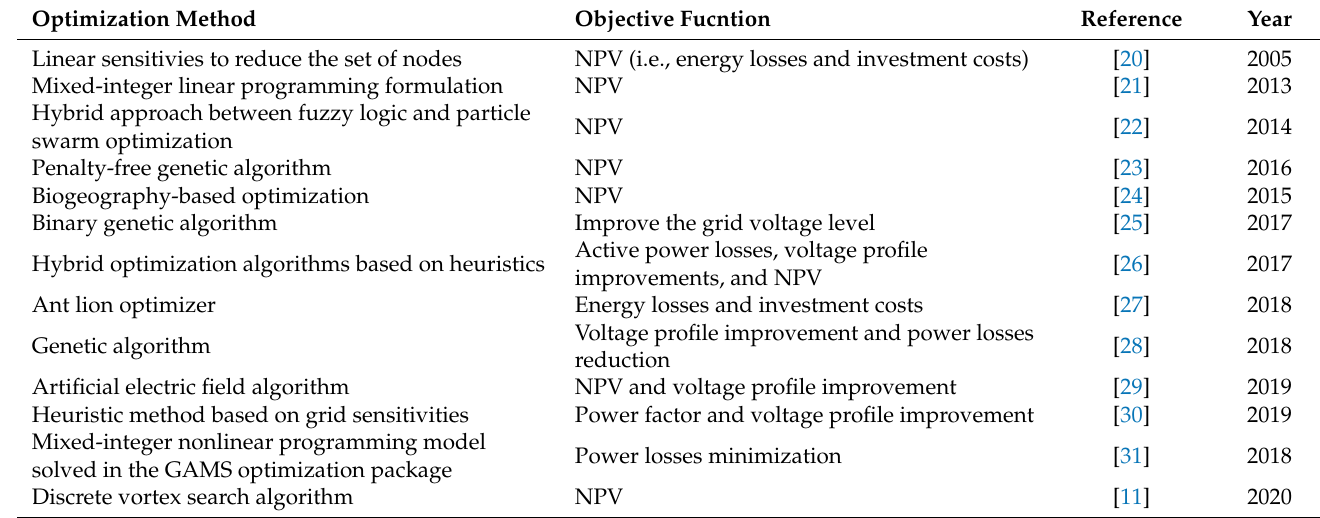
Table 1. Summary of the main approaches reported in the literature regarding optimal placement and sizing of fixed-step capacitor